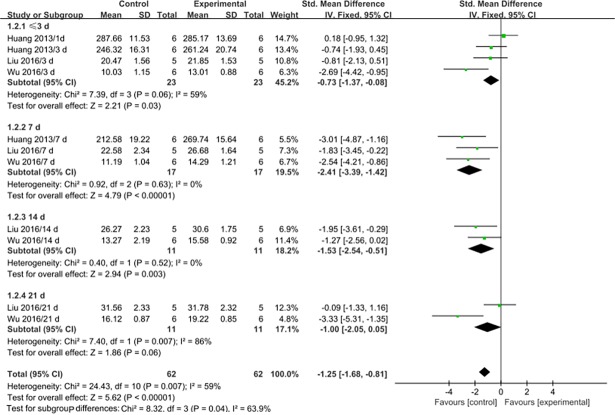
Forest plots showing the effects of MSCs on SOD levels.Control: PQ group; Experimental: MSC treatment group; CI: confidence interval; IV: independent variable; SD: standard deviation.